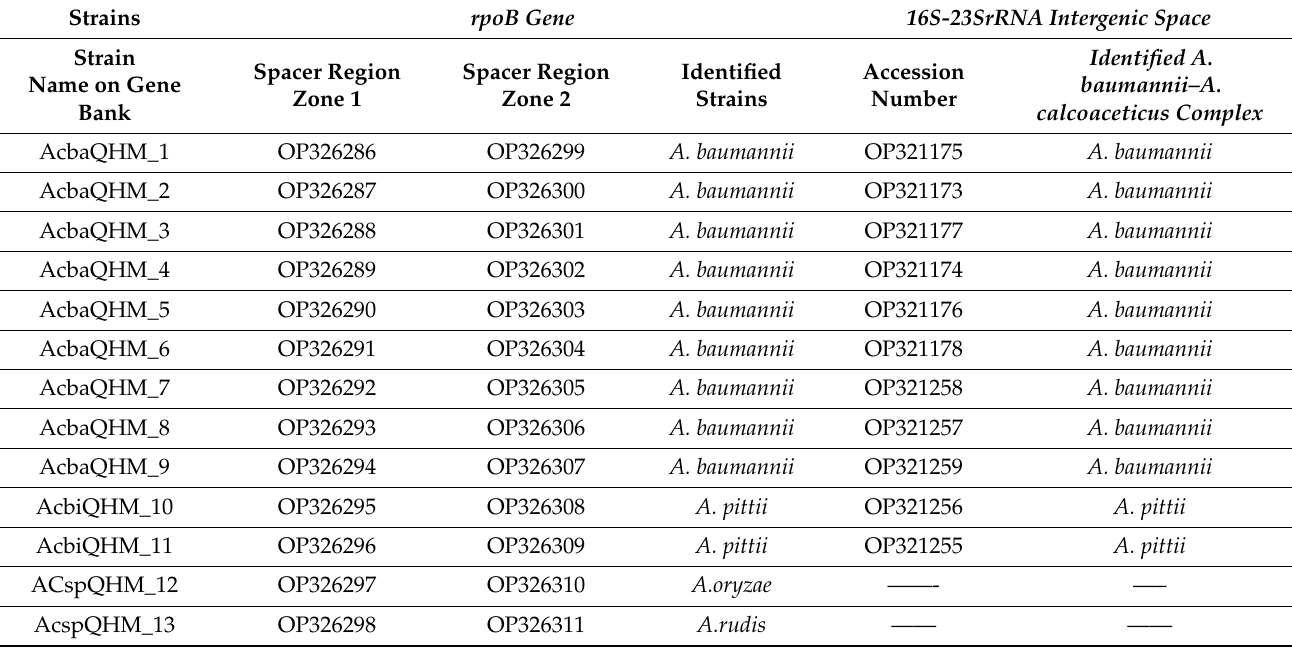
Table 1. Accession numbers of Acinetobacter spp. for sequenced rpoB and 16S-23S ribosomal RNA intergenic